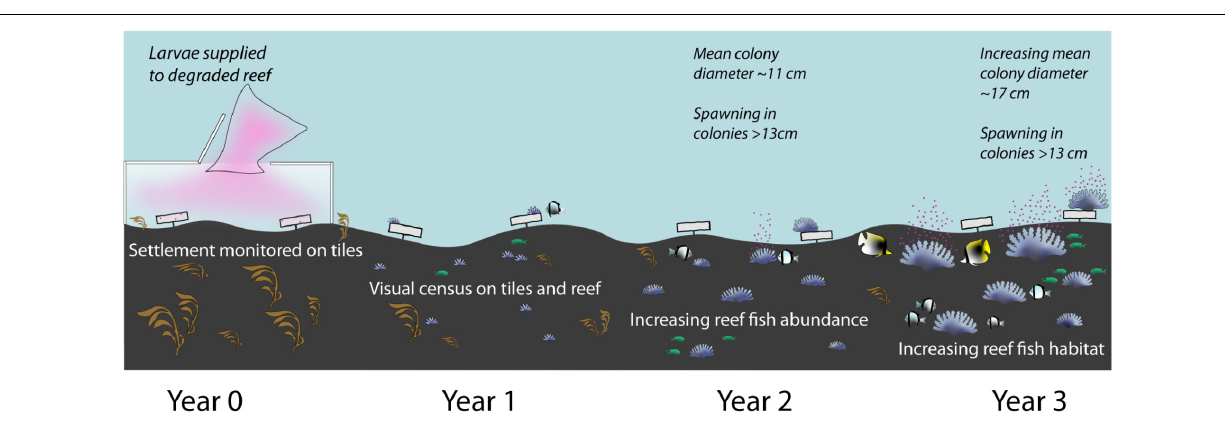
FIGURE 12 | Non-metric multidimensional scaling (nMDS) plot showing patterns in fish assemblages in the larval-enhanced ( N = 3) and control ( N = 3) plots from 2016 to 2019.